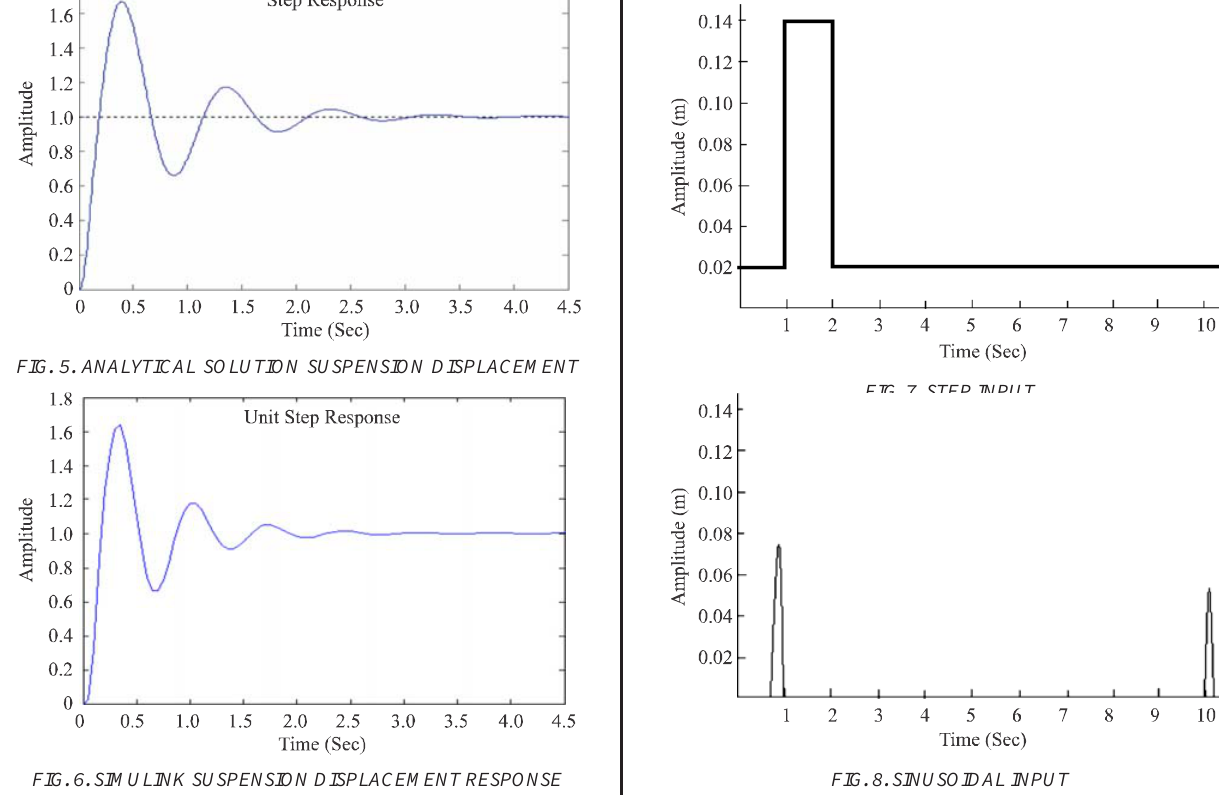
FIG. 5. ANALYTICAL SOLUTION SUSPENSION DISPLACEMENT